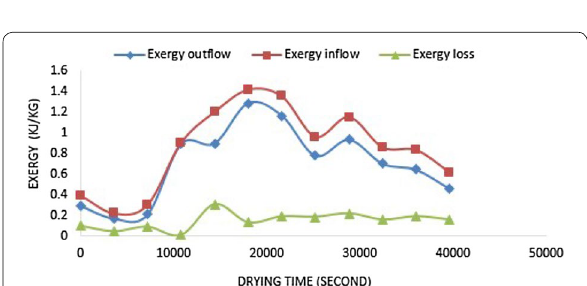
Fig. 13 Exergy as a function drying time (4th day) onion